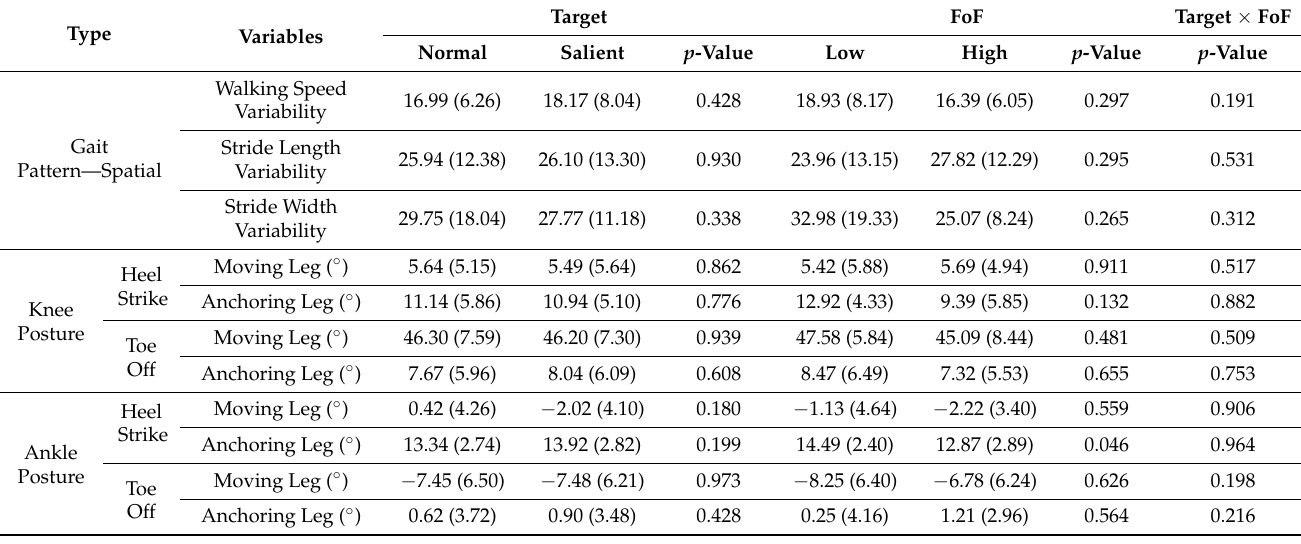
Table A1. Mean, SD values, and ANOVA results of other gait and posture